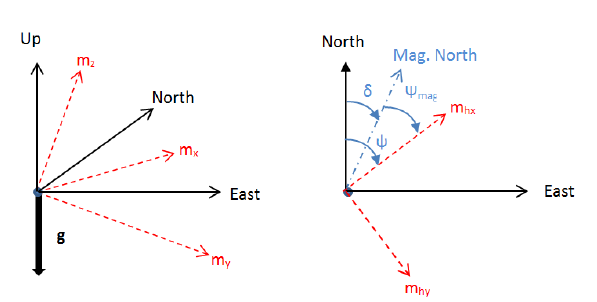
Figure 13. Determination of the heading angle ψ from magnetometer